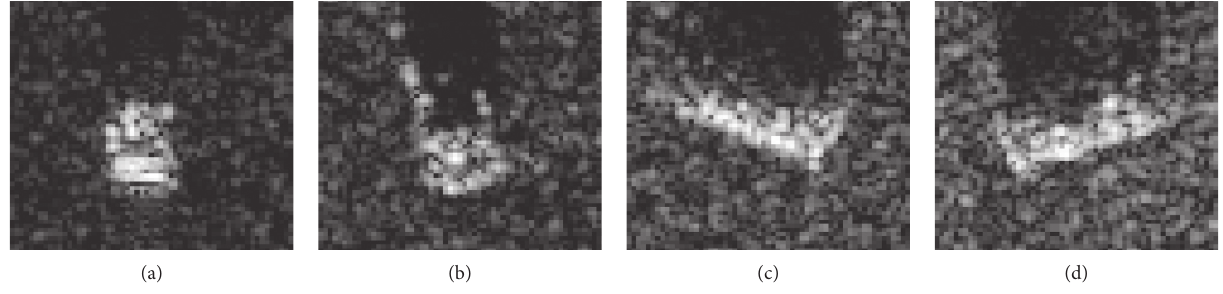
Figure 1: SAR images of the same target from different azimuths: (a) 5 ° ; (b) 20 ° ; (c) 80 ° ; (d) 300 °